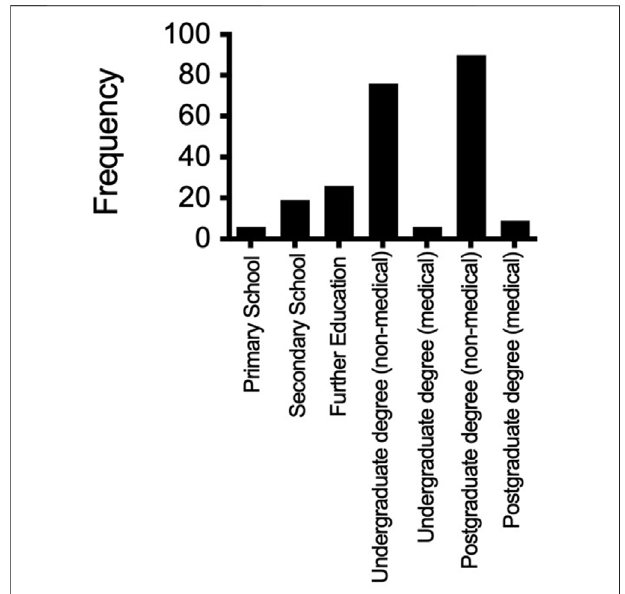
FIGURE 2 | Education attainment of